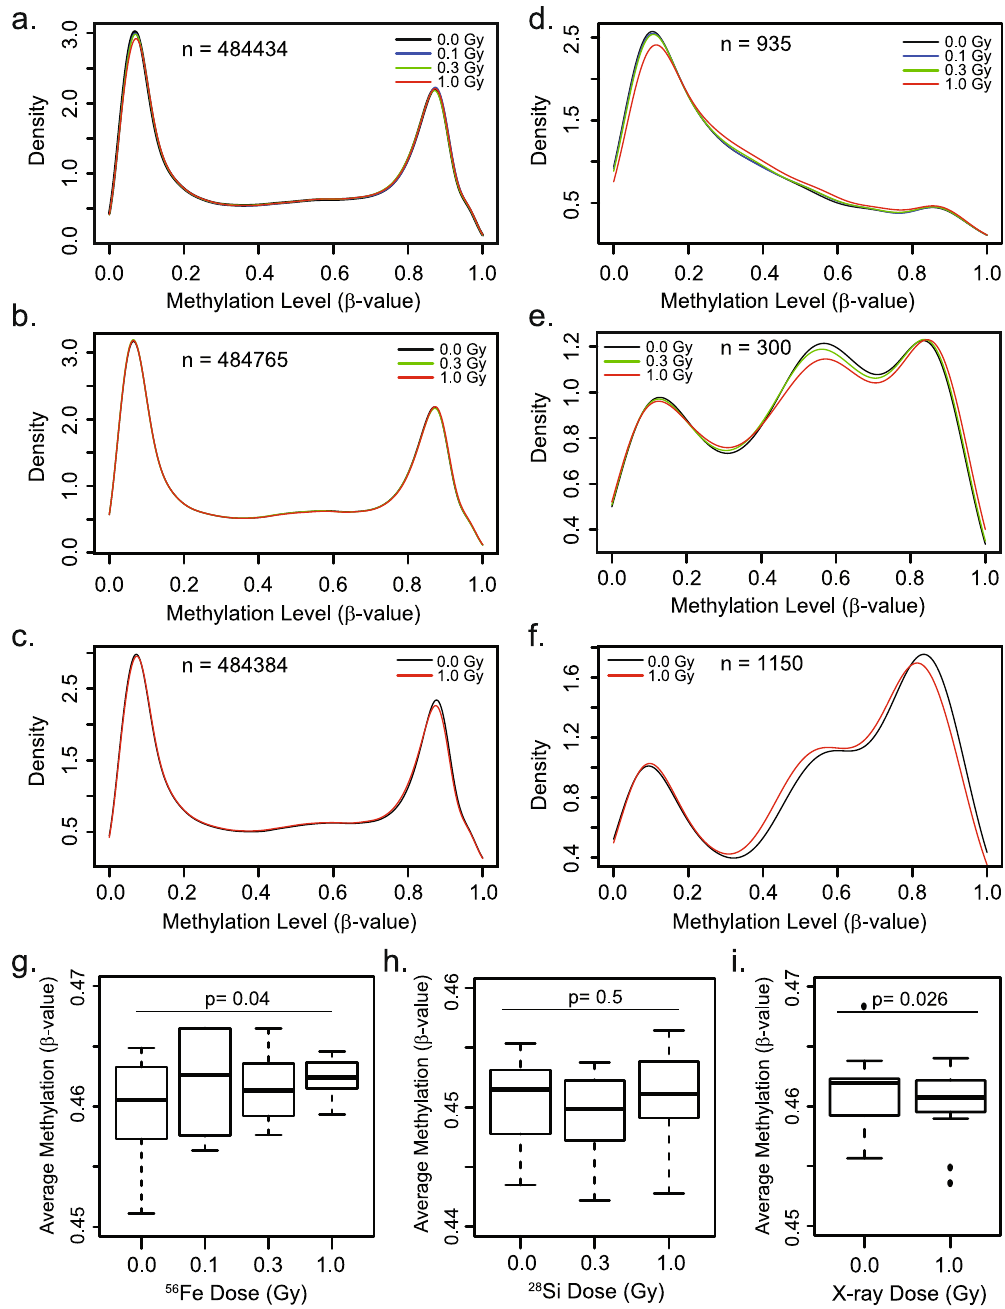
Figure 1. Global impact of high- vs. low- LET radiation on DNA methylation. ( a – f ) Density plots showing the impact of the indicated dose of each radiation source on the distribution of DNA methylation values ( β values) across all time points, for all evaluable ( > 484,000 CpG sites on the array passing QC) CpG sites ( a – c ) or the subset of CpG sites whose methylation status was found to be significantly associated with increasing dose of 56 Fe, 28 Si or X ray exposure ( d – f ). ( g – i ) For each sample, the average methylation ( β value) across all evaluable CpGs ( > 484,000 CpG sites) was determined. Box plots representing the distribution of the average methylation level across all 12 samples (3 replicates x 4 time points) for the indicated dose/source. The line represents the median average methylation level, boxes the first and third quartiles, whiskers represent the interquantile distance. Note the trend towards hypermethylation with increasing 56 Fe ion dose (p = 0.04) and towards hypomethylation with X ray dose (p = 0.026). No significant directional trend was observed with 28 Si exposure. P-values were determined as a regression of the mean beta value across all samples with dose, with covariates for time, batch and